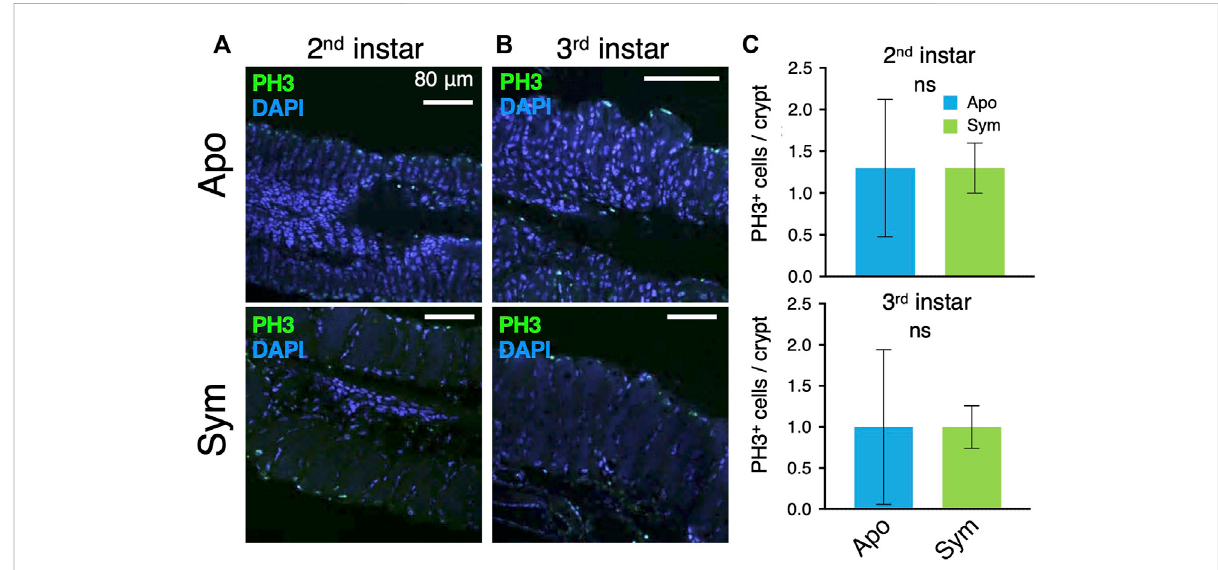
FIGURE 3 Mitoticcellsinsymbioticorgansofaposymbioticandsymbioticinsects.MitoticcellsarevisualizedbyimmunostainingofPH3.LSMimagesof (A) second instar and (B) third instar insects. Green and blue are derived from anti-PH3 and DAPI staining, respectively. (C) The number of PH3-positive cells per crypt ( n = 9). The data was analyzed by the Mann-Whitney U test (ns, non-signi fi cant). Apo, aposymbiotic; Sym, symbiotic